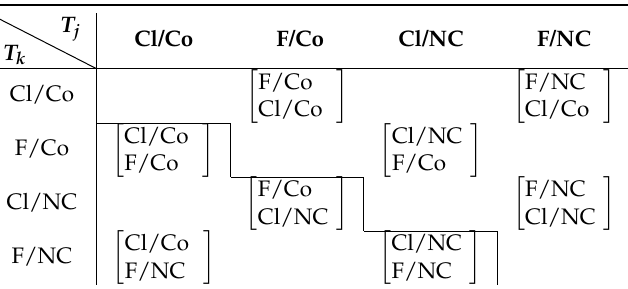
Table 2. Possible cases when selecting from two